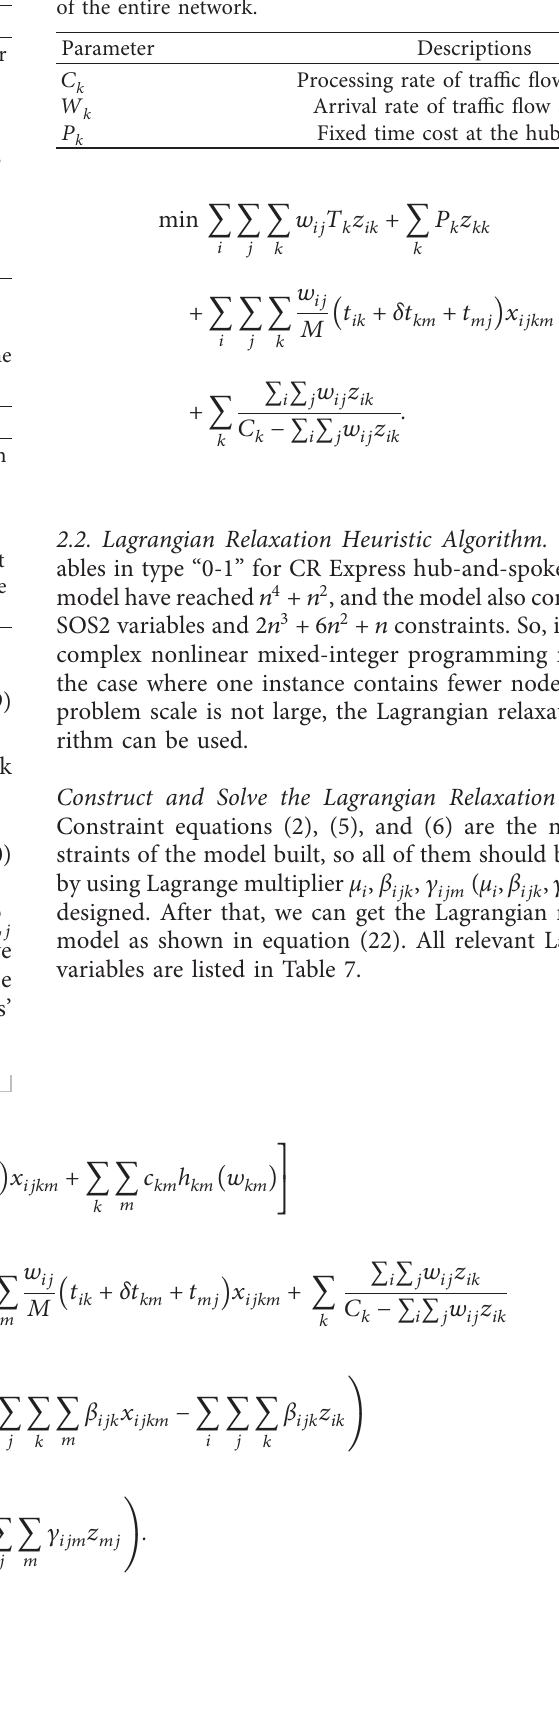
Table 4: The variables in the SOS2